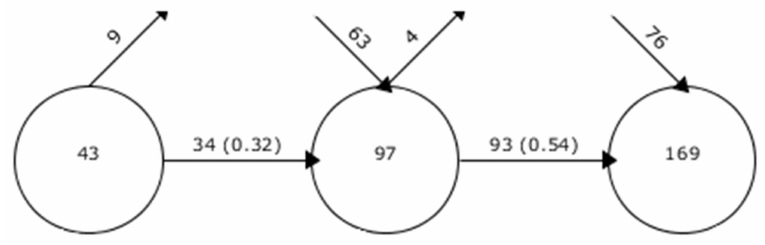
Figure 12. Overlay graph.